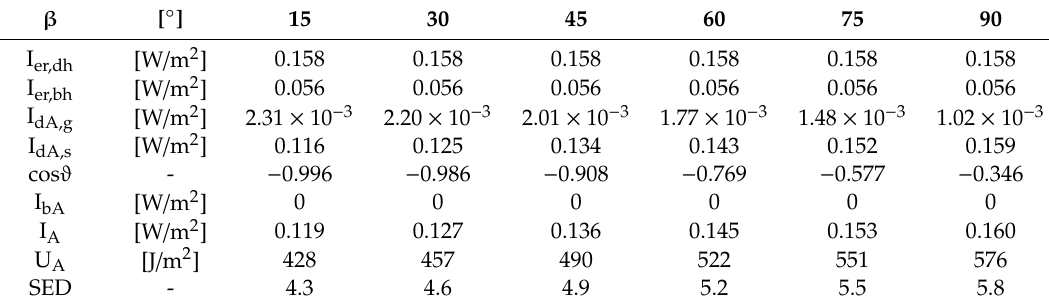
Table 5. Calculation results for sloped surfaces facing the north direction (21 June, solar